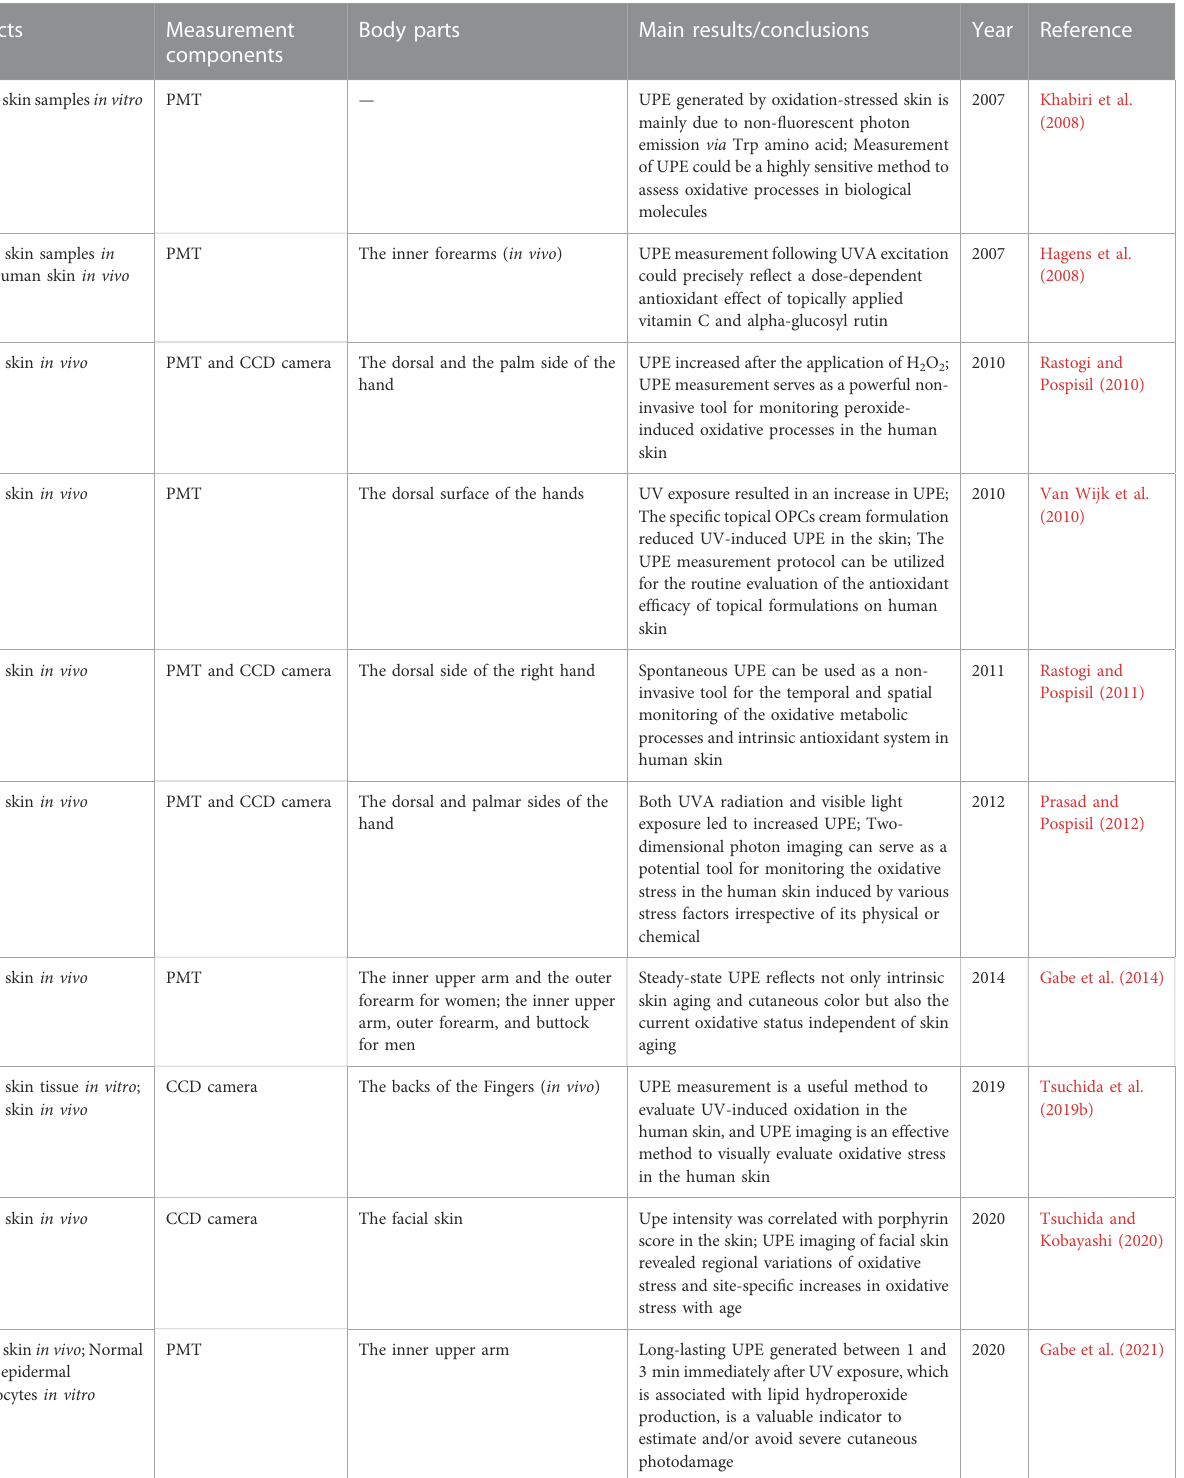
TABLE 1 Studies on the association between UPE and skin